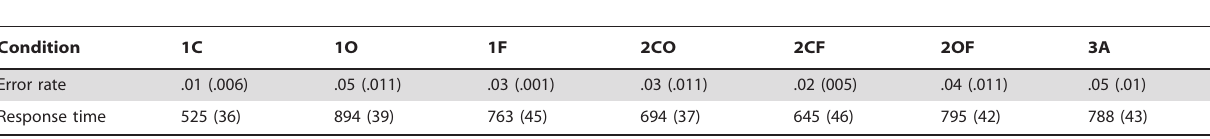
Table 2. Response by arity-dimension